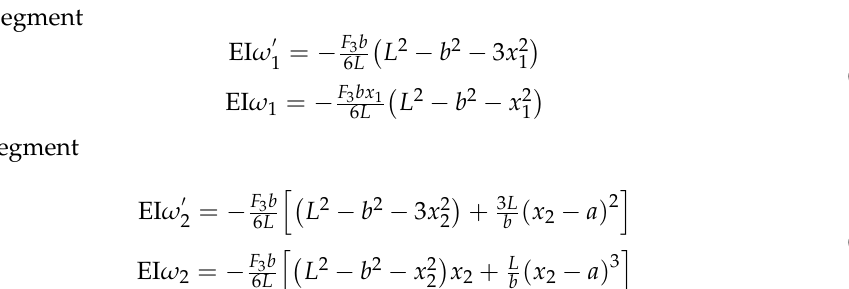
Figure 5. Fiber deformation due to concentration.